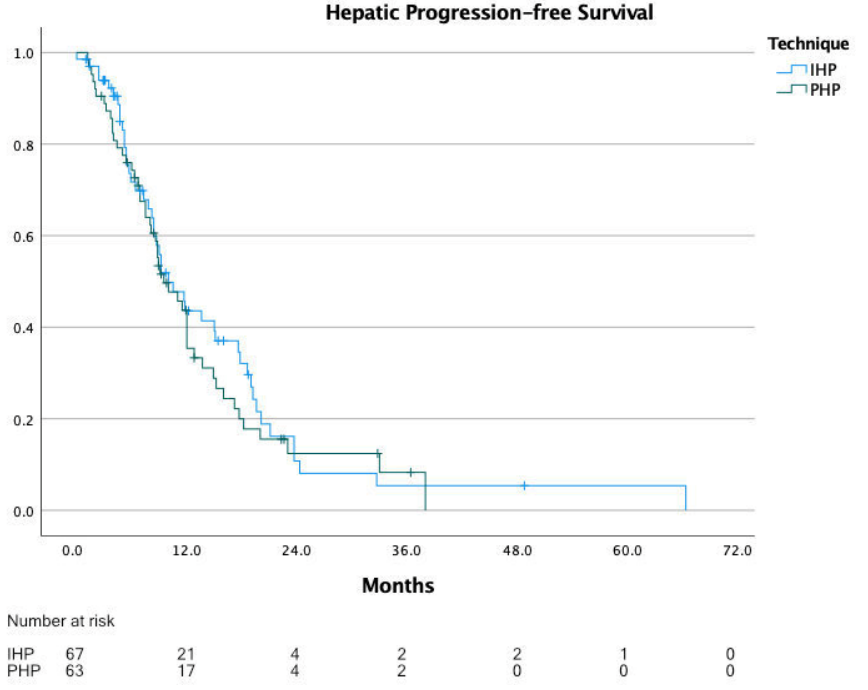
Figure 4. Progression ‐ free survival.